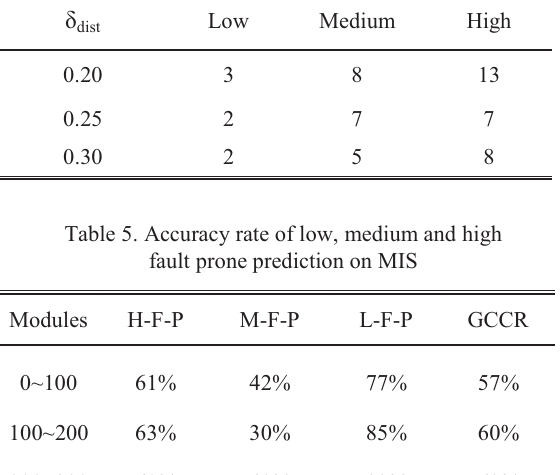
Table 3. Accuracy rate of low, high fault prone